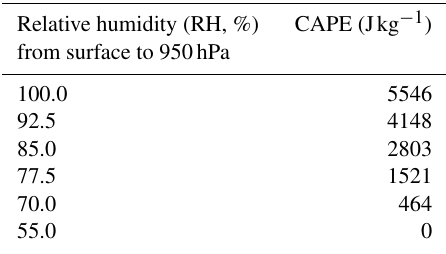
Table 5. The CAPE values of experiments with different near- surface moisture